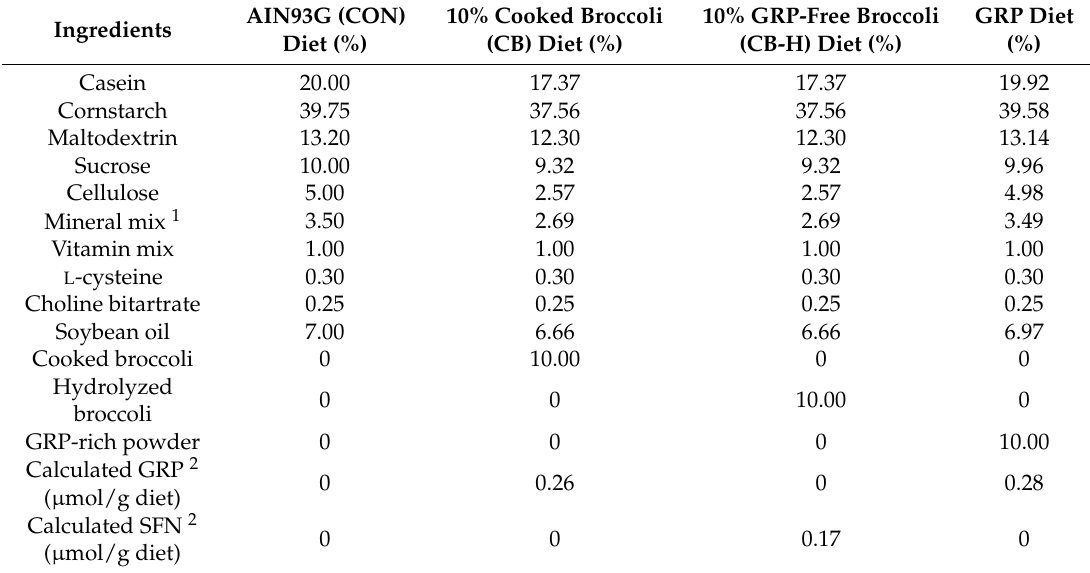
Table 1. Diet Compositions (%) 1